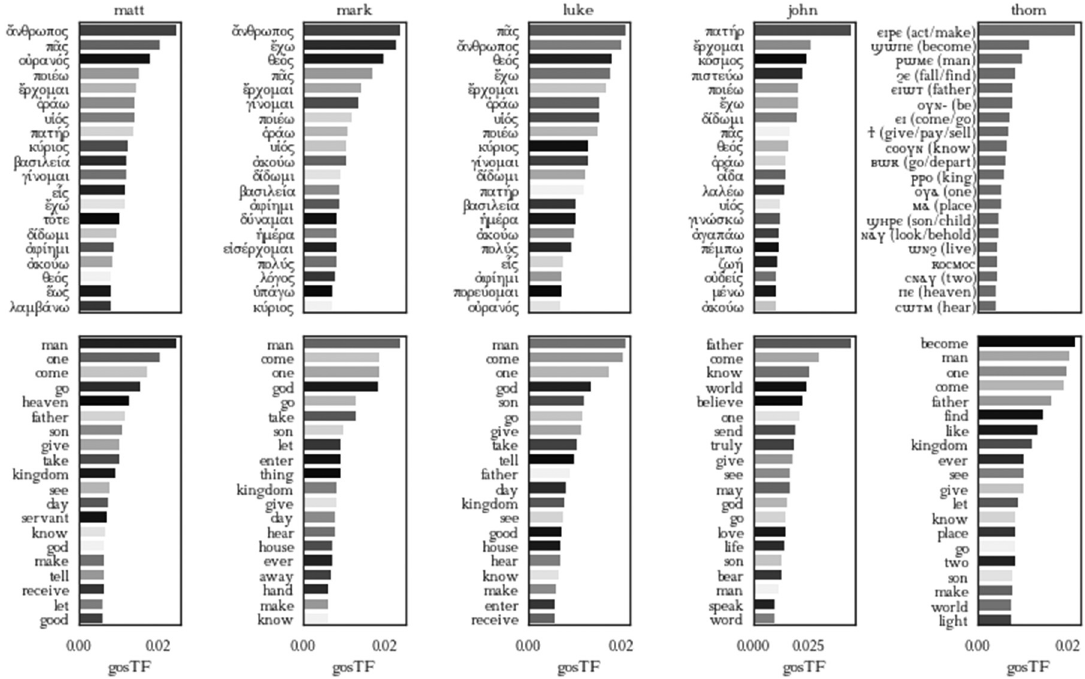
Figure 2: Twenty terms with the highest gosTF in the fi ve Gospels. Where di ff erentiated, the color scale depicts the term frequency within the Gospel in ratio to its frequency in all Gospels together; darker color signi fi es a higher ratio, and thus a higher speci fi city of the given term for the given